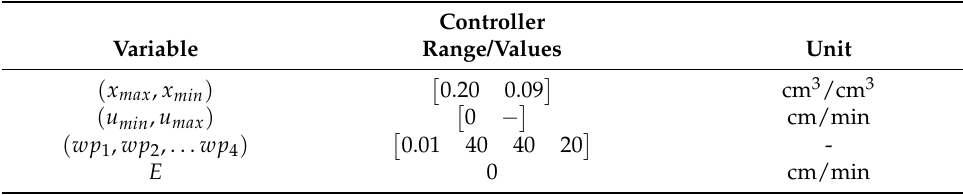
Table 3. Table of constraints and weights for